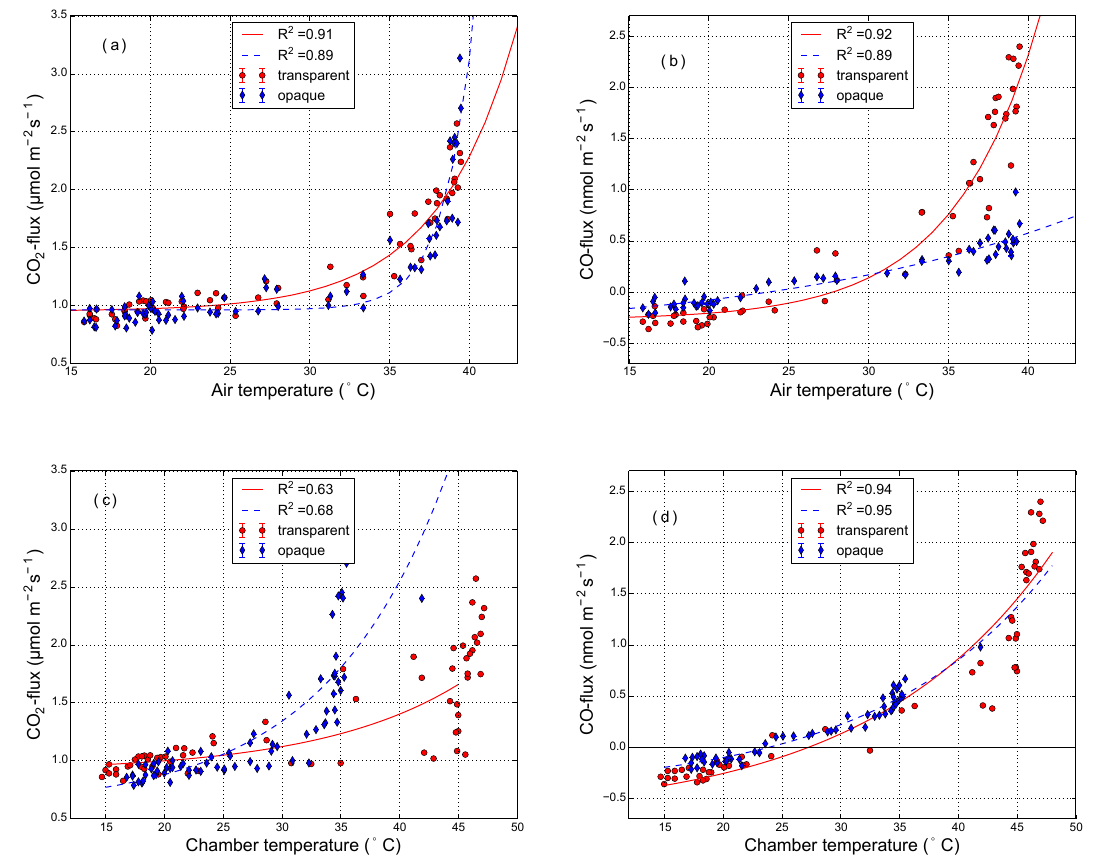
Figure 3. Transparent and opaque flux chamber CO 2 fluxes (left) and CO fluxes (right) vs. air temperature (a, b) and chamber temperature after 6min closure (c, d) . Regression coefficients of polynomial fits are given in the